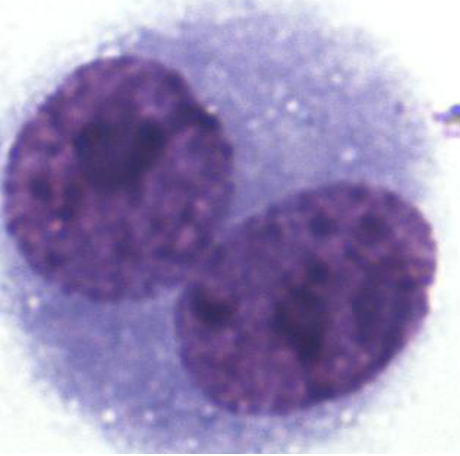
Figure 1. Binucleated cell (BNC) of blue fox; Giemsa staining.